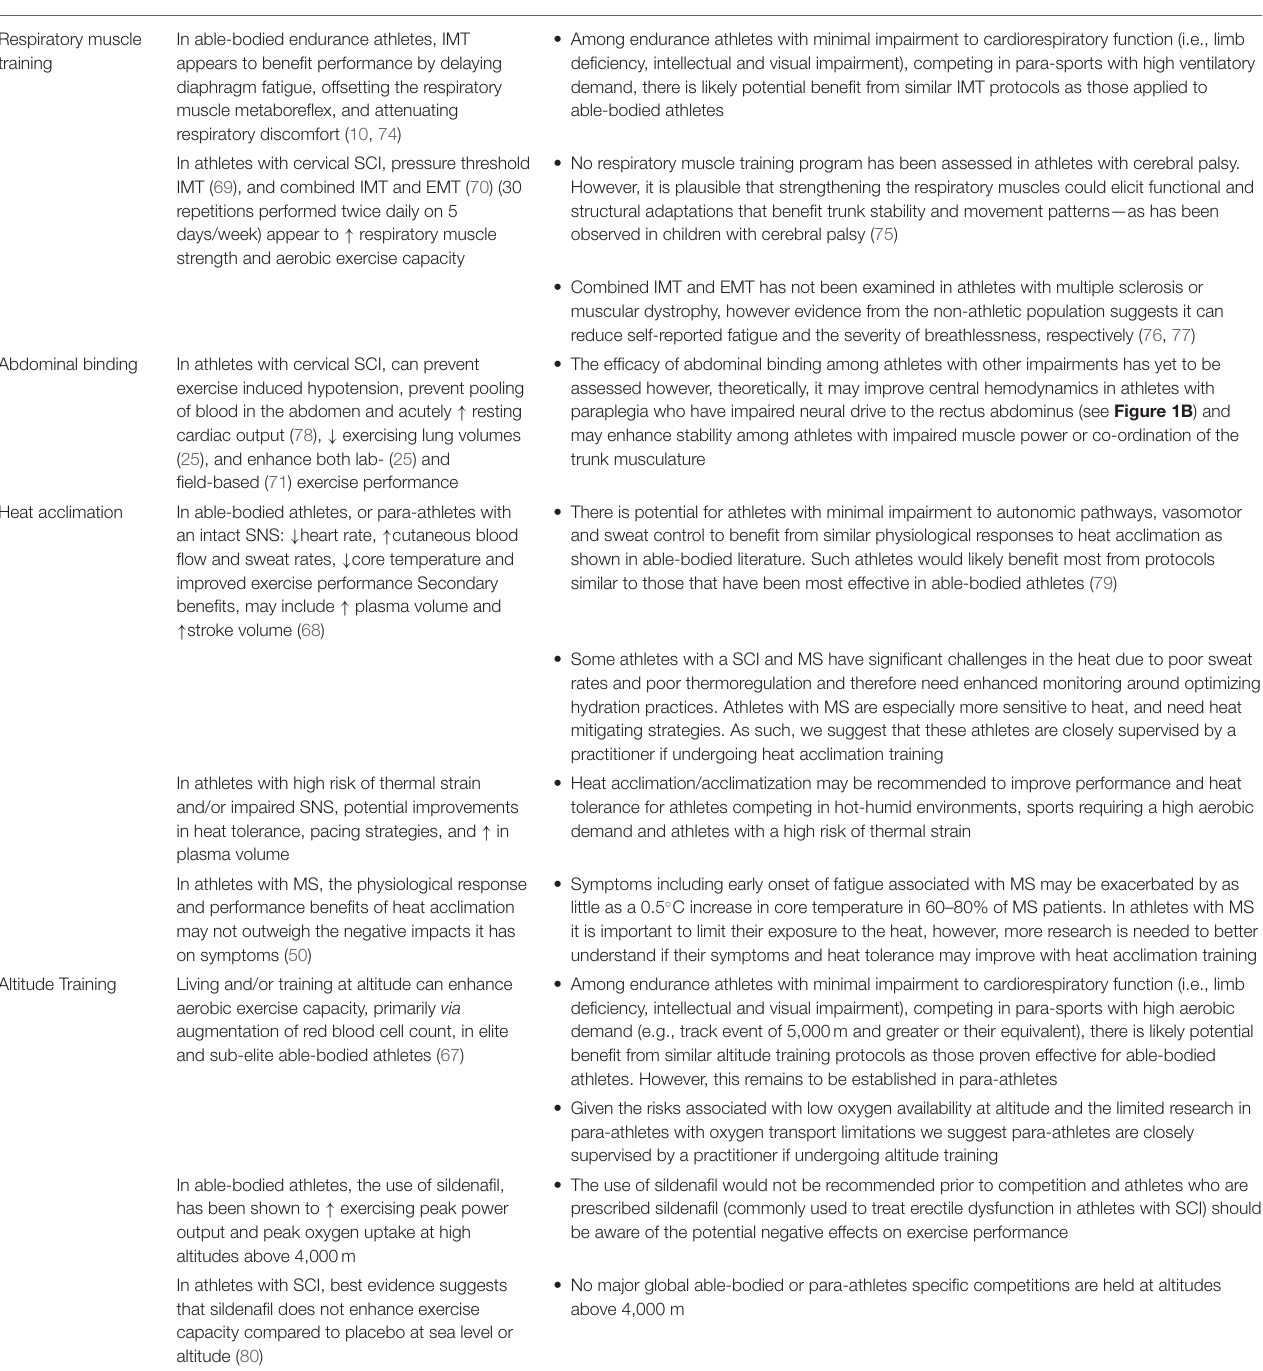
TABLE 2 | Key physiological interventions specific to